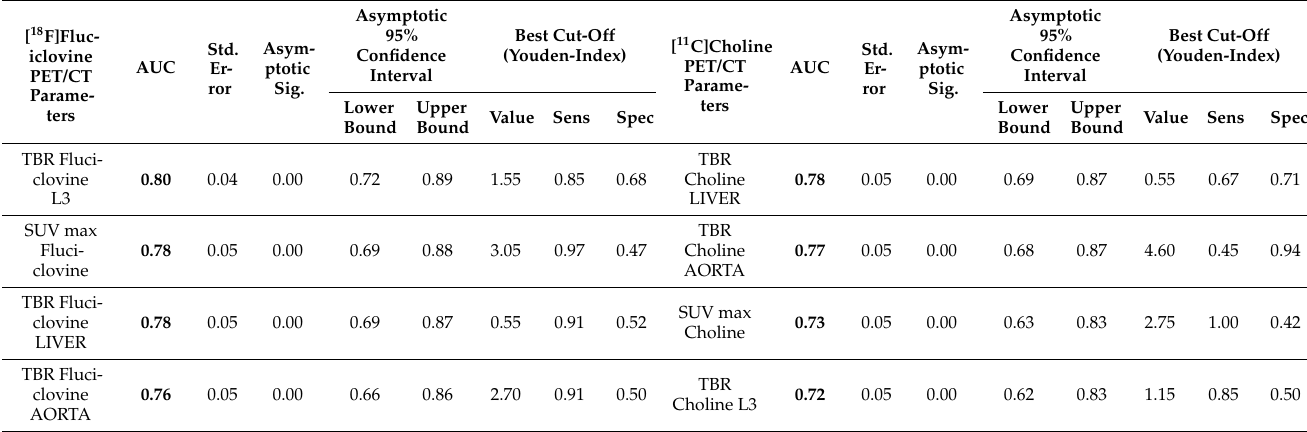
Figure 2. Receiver operating characteristics (ROC) curves of [ 18 F]Fluciclovine ( A ) vs. [ 11 C]Choline PET/CT ( B ) performance for clinical significant lesion (pISUP 2–5) detection, using semi-quantitative parameters (lesion-based, n = 33/95). Table 5. Comparison of [ 18 F]Fluciclovine vs. [ 11 C]Choline PET/CT performance for clinical significant lesion (pISUP 2–5), using semi-quantitative parameters (lesion based, n = 33/95). Areas under the ROC curves (AUCs) are listed (in bold) in descending order. Best cut-off values for each parameter and corresponding sensitivity (sens) and specificity (spec) are also